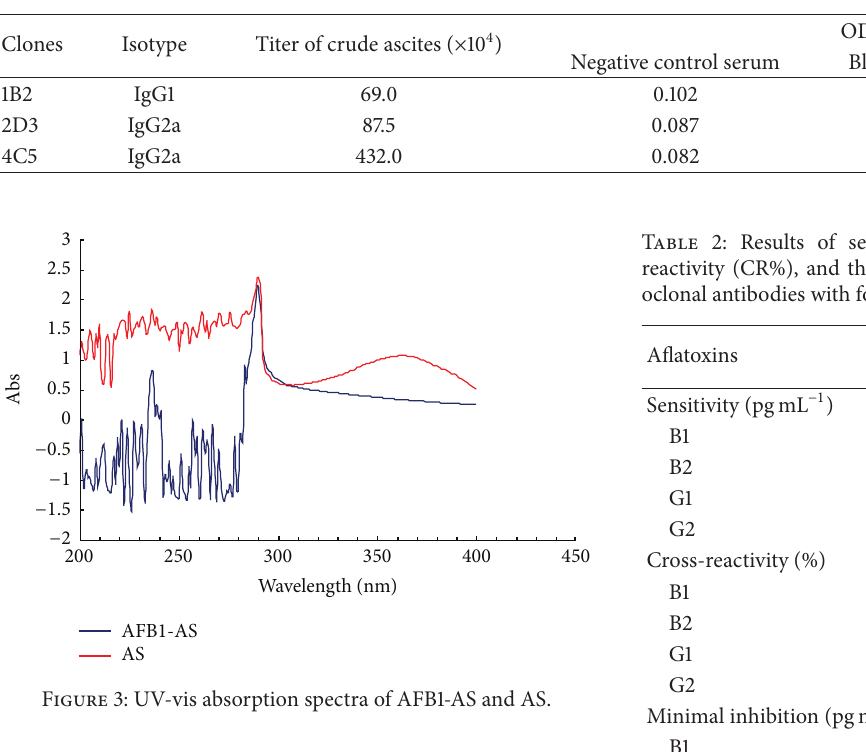
Table 1: Results of titers and isotypes of ascites antibodies.